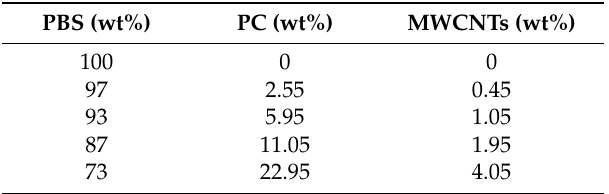
Table 1. Weight percentages of the components in the